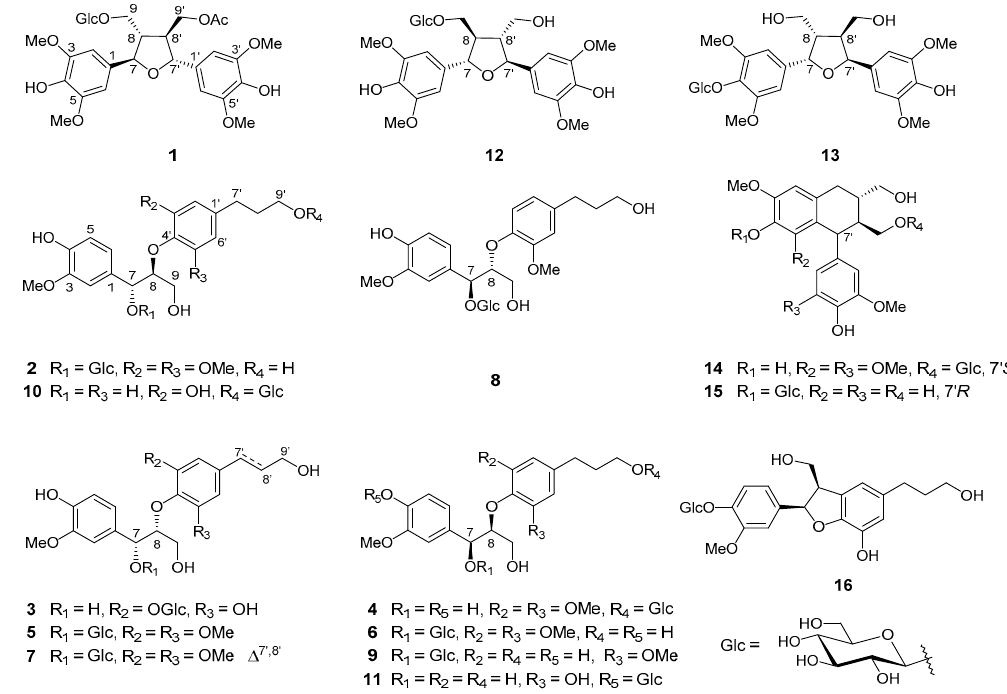
Figure 1. Structures of compounds 1 – 16 from U. lobate.